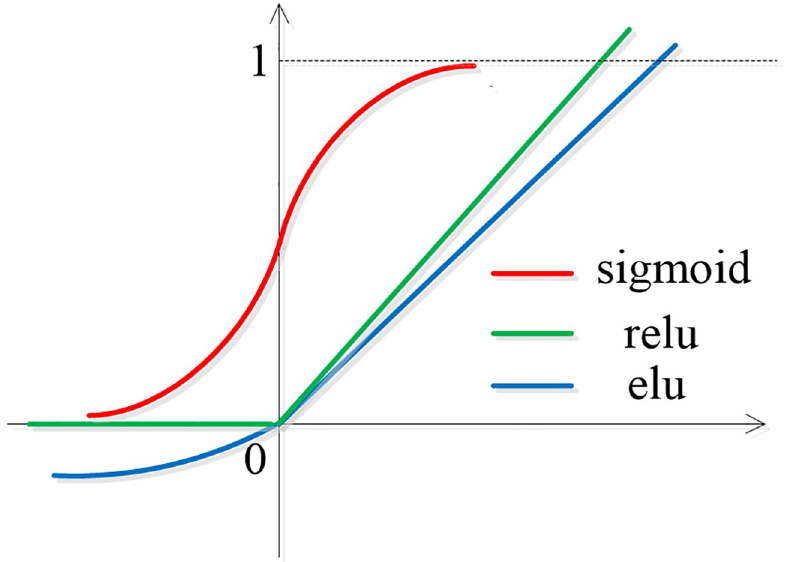
Fig 3. Diagram of activation function.